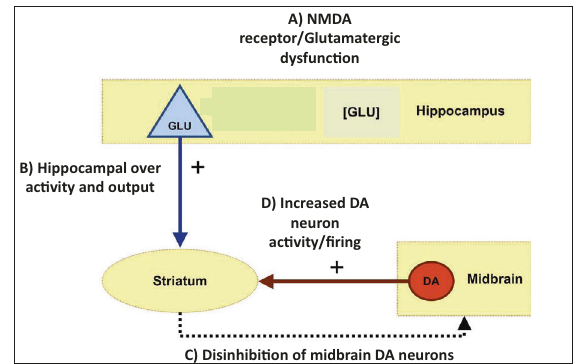
Fig. 1 Preclinical model of the hippocampal — striatal-midbrain circuit. A ) Hippocampal glutamatergic function B ) drives hippo- campal activity and output to the striatum that C , D ) deregulates striatal dopamine function in